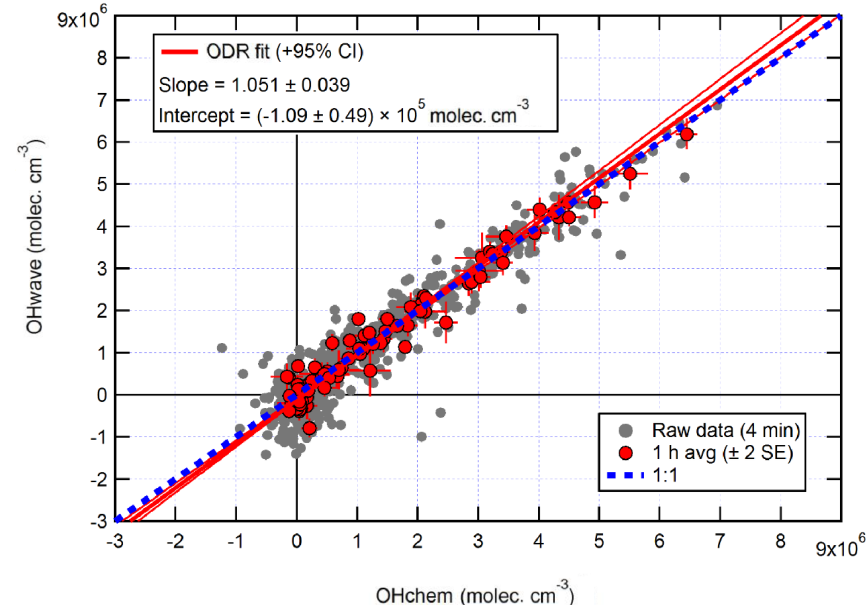
Figure 12. Overall intercomparison of OH wave and OH chem observations from the winter 2016 AIRPRO campaign. Grey markers represent raw data (4min), with 1h averages ( ± 2 SE) in red. The thick red line is the ODR fit to the hourly data, with its 95% CI bands given by the thin red lines; fit errors are given at the 2 σ level. For comparison, 1 : 1 agreement is denoted by the dashed blue line. OH wave data were corrected for the known interference from O 3 + H 2 O.